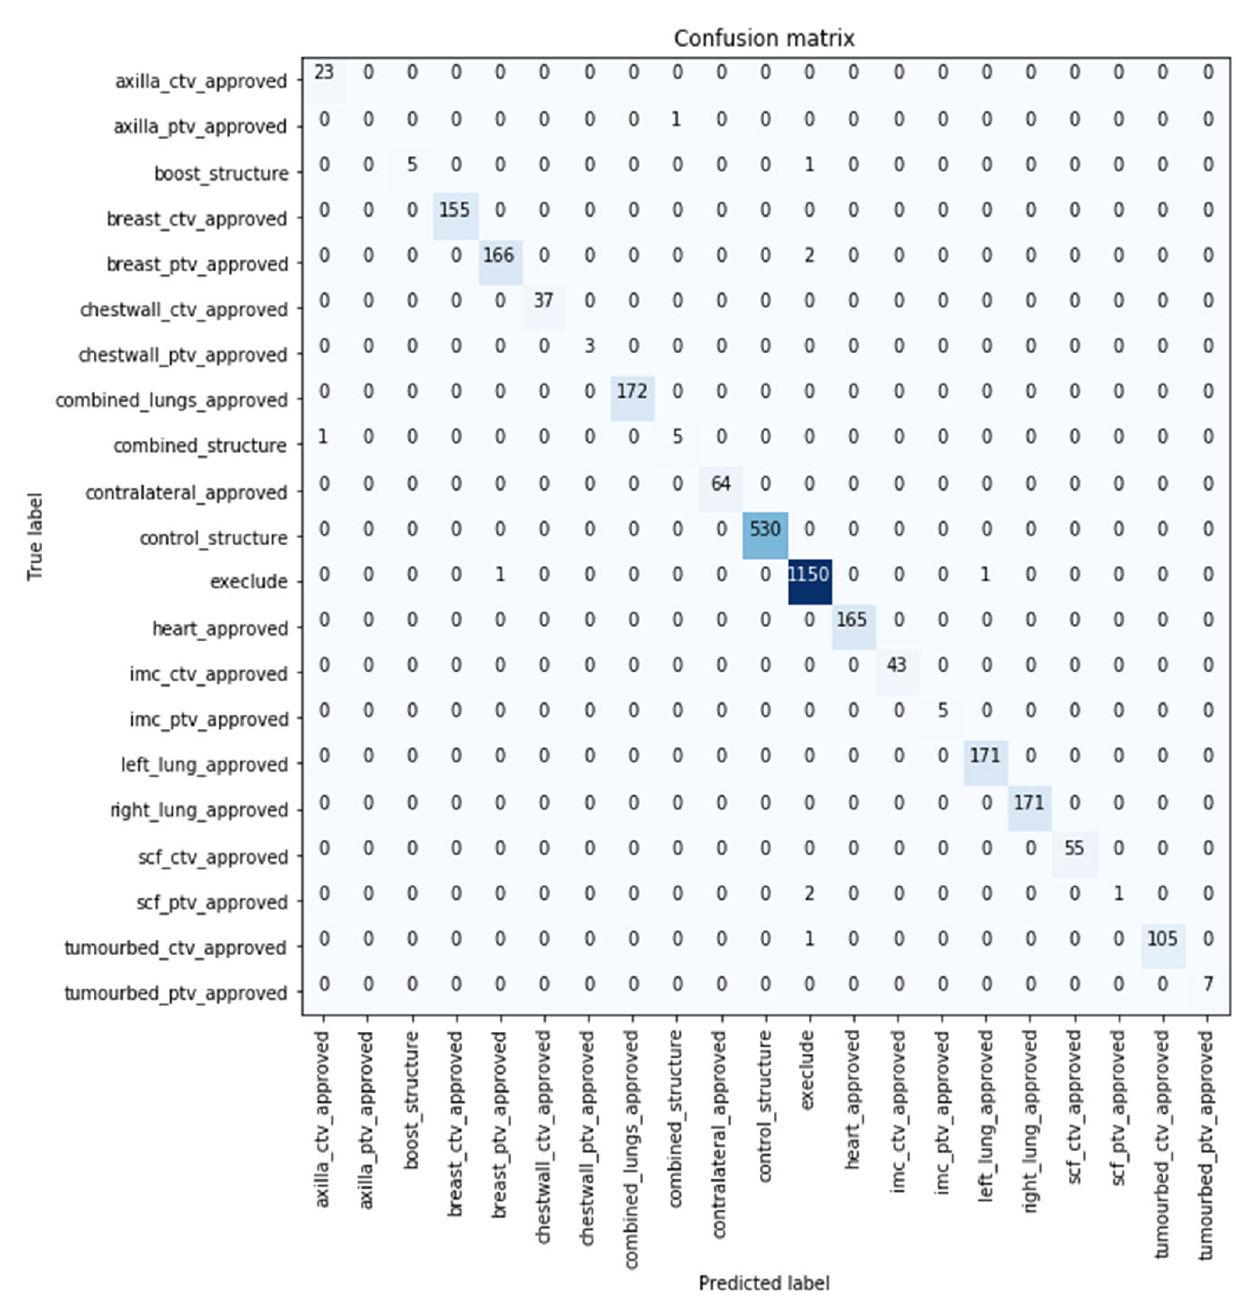
Figure 3. Confusion matrix of the best performing model over the test dataset.